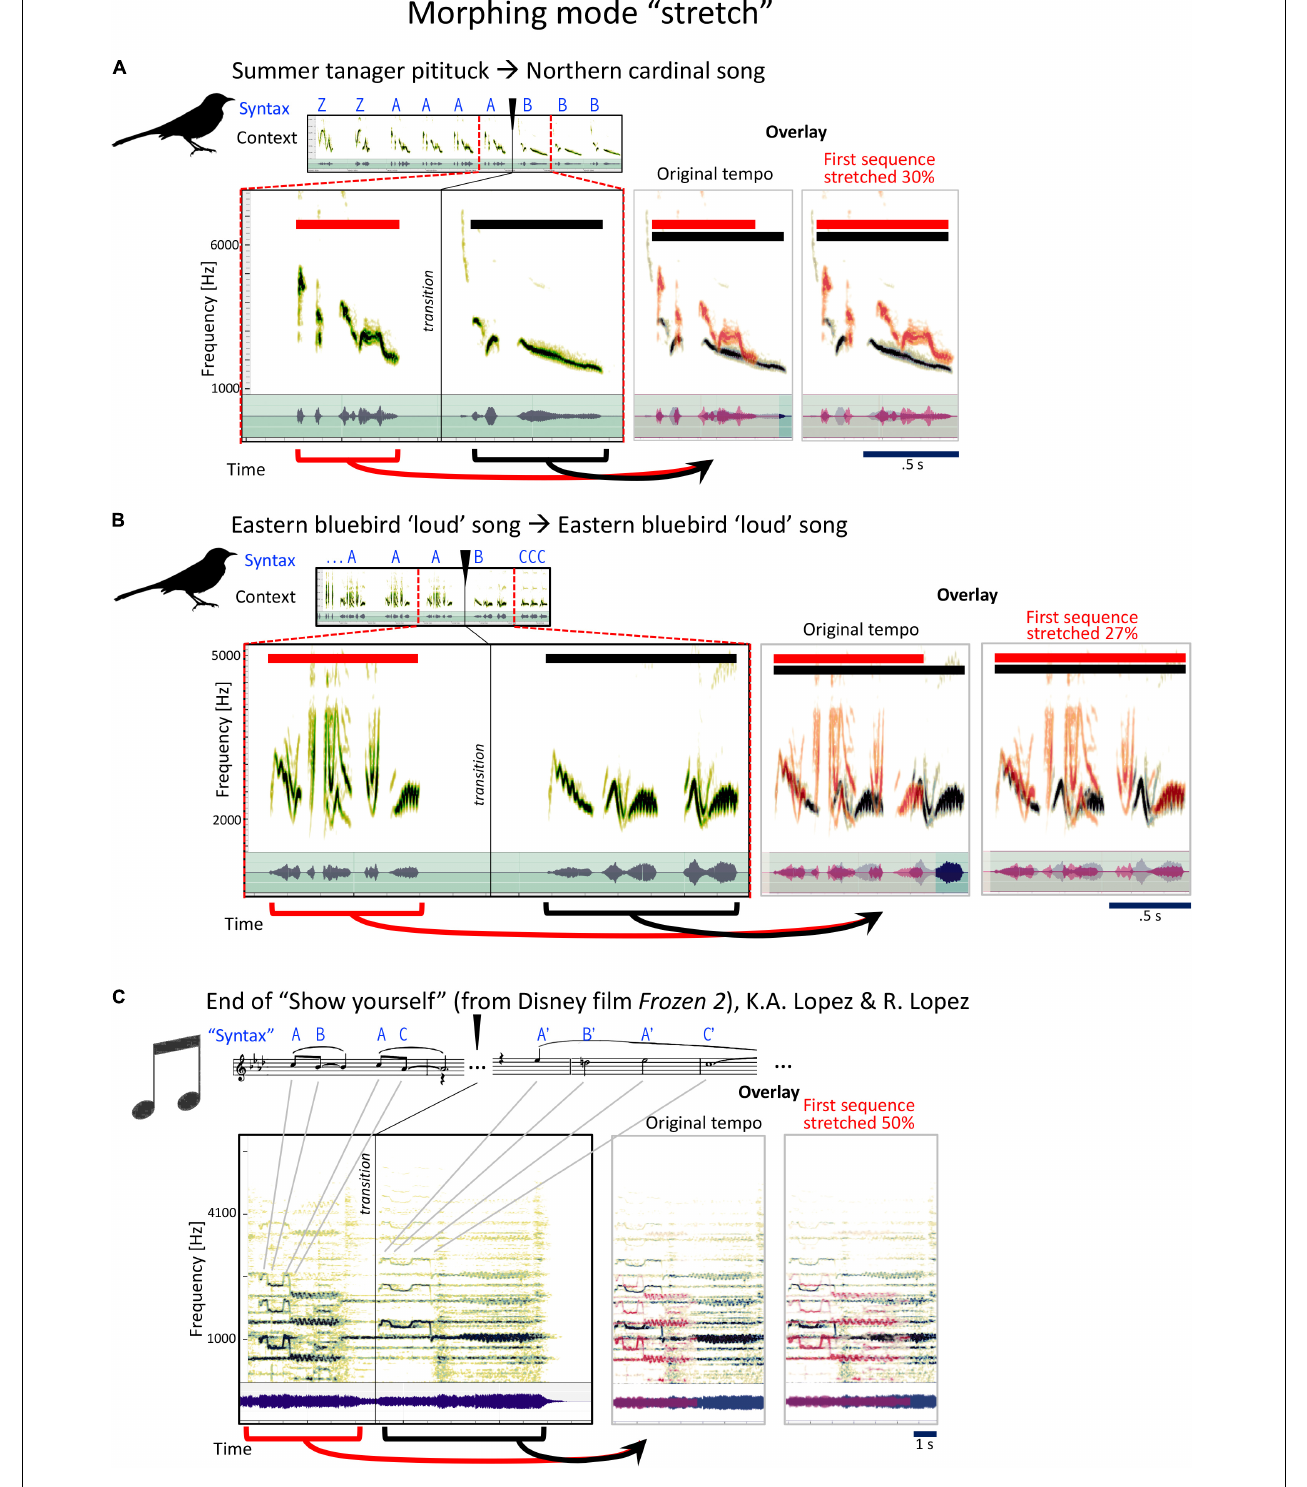
FIGURE 6 | Examples for the mockingbird morphing mode “stretch,” and example for a similar musical strategy. (A,B) Spectrograms and waveforms (as in Figure 4 ) for two examples of phrase transitions representing “stretch” morphing, in which a phrase is followed by a similar, but slowed-down phrase. Note that both examples also include additional changes in timbre and/or pitch. (C) The end of the song “Show yourself” from the Disney film Frozen 2 follows a similar strategy, with a four-note sequence repeated at half the tempo (this example also includes a pitch change).